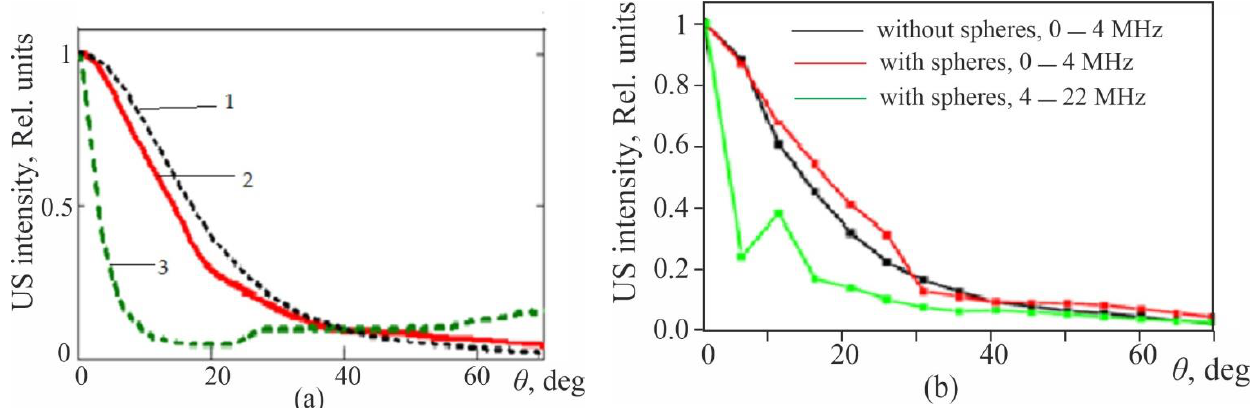
Figure 7. Experimental and model US spectra generated with 1 µ m sphere coating. ( a ) Experimental US spectra with sphere coating (red) and without coating (black) [8]. ( b ) Model US spectra: 1—spectrum of exciting laser radiation. 2—without spheres from a clean fiber spectrum; 3—spectrum with spheres; diameter of the spheres is 200 μm.